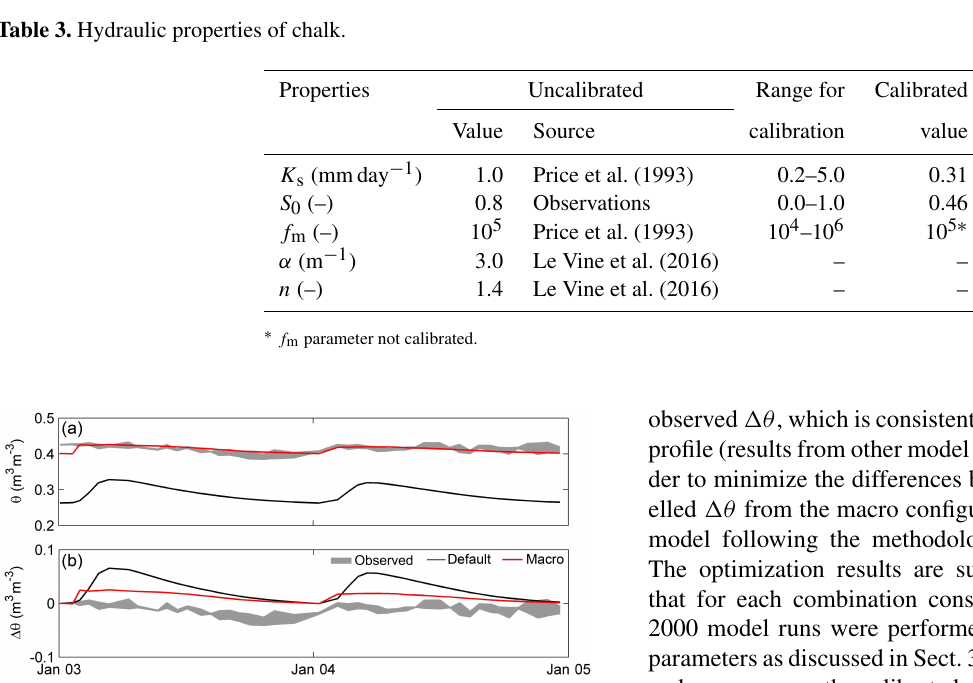
Figure 3. Comparison between observed and simulated (a) soil moisture ( θ ) and (b) change in soil moisture ( (cid:49)θ ) from the default and macro configurations at a depth of 2m below the land surface at the Warren Farm site. The shaded areas constructed from two soil moisture probes at the Warren Farm site denote the range of ob- served data in these